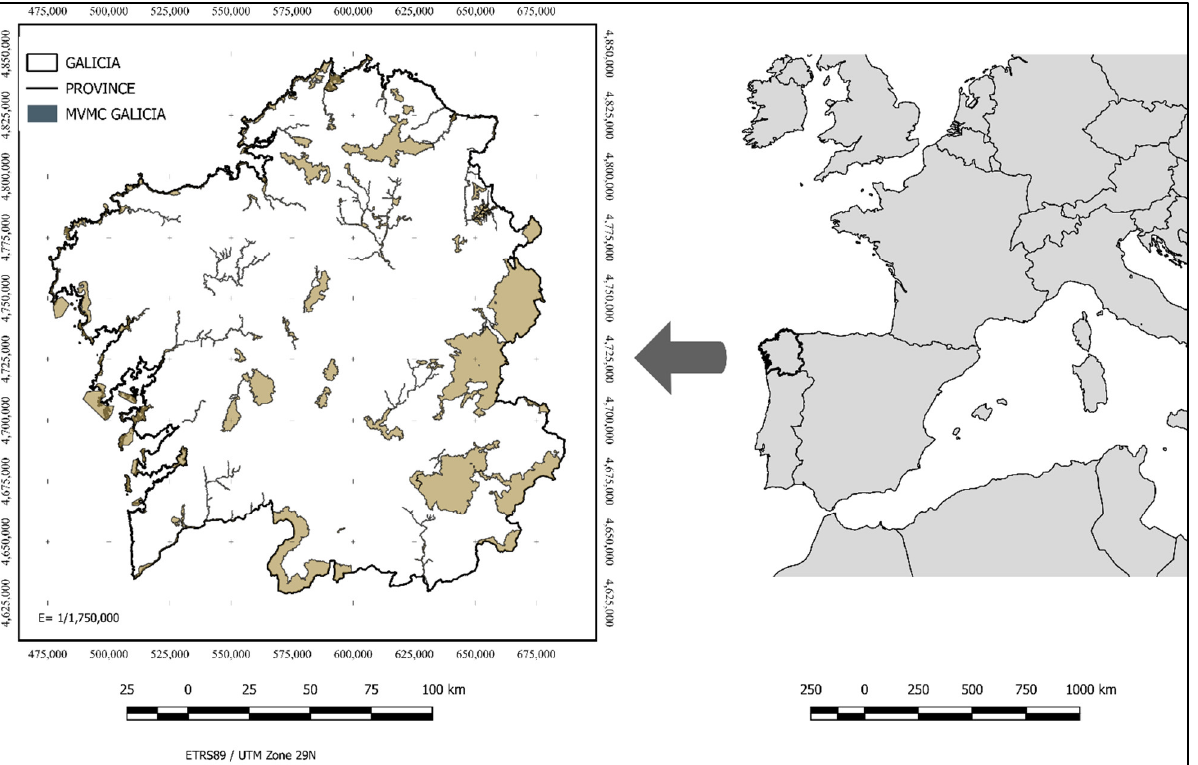
Figure 1. Location map with the distribution of the MVMCs (neighbouring forests in common ownership) and SACs (special conservation areas) in Galicia.